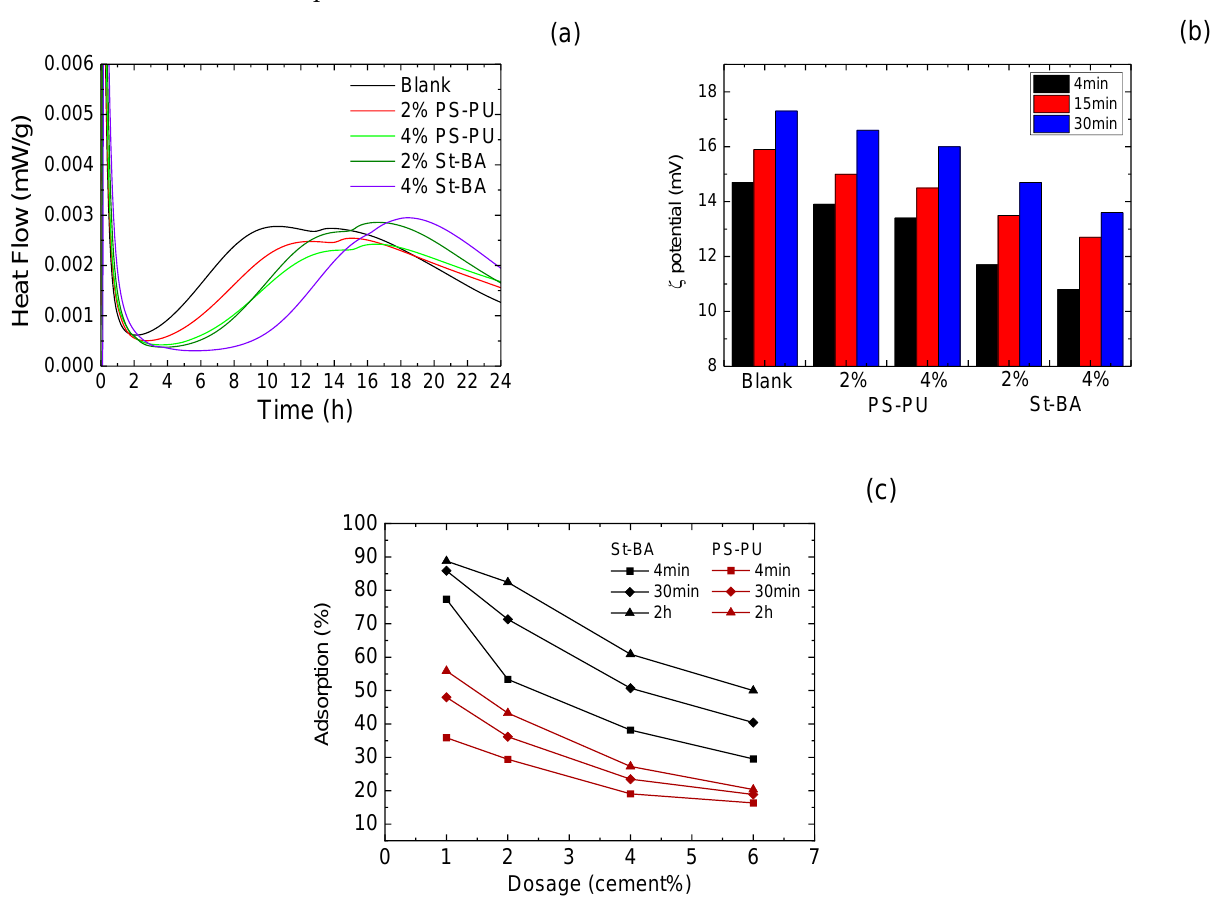
were deduced from the curves were in agreement with results from direct measurement on pastes.